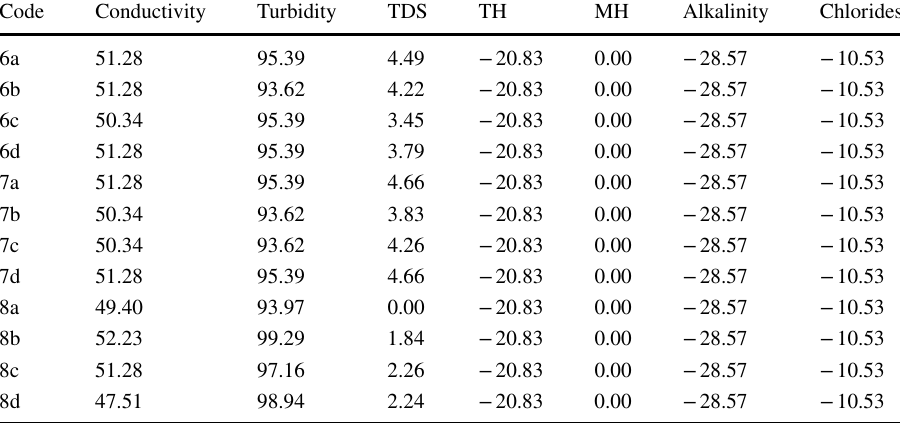
in various physicochemical parameters of surface water after treatment with blended coagulant (alum + chitin—1:4